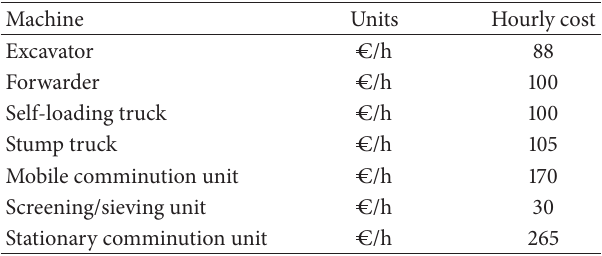
Table 3: Hourly machine costs used in the